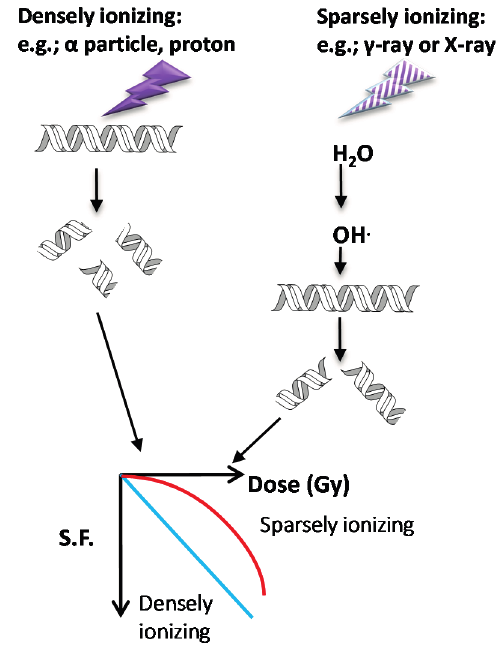
Figure 2. Effects of different radiation types on DNA damage and cell survivals.